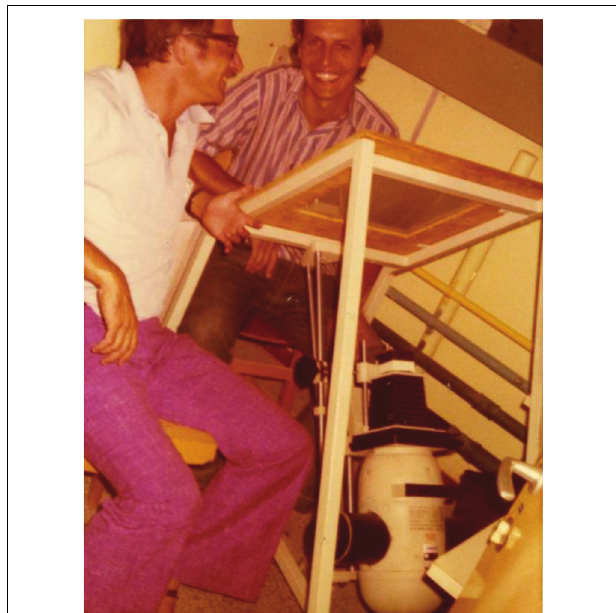
FIGURE 1 | Conrad (R) and Arieh (L) at the unique “Chezi” 30 mm-film projector, manually measuring cell dimensions and constrictions, Be’er-Sheva, Summer 1976. This primitive, bulky “machine” was designed and constructed by the Workshop of the Natural Sciences Faculty at Ben-Gurion University, led by Mr. Yechezkel Tahori in the “pre-history” of computer visualization, initiated in the University of Amsterdam by (Trueba and Woldringh, 1980) and developed further into a versatile measuring plugin “ObjectL,” which runs under ImageJ (see Vischer et al.,